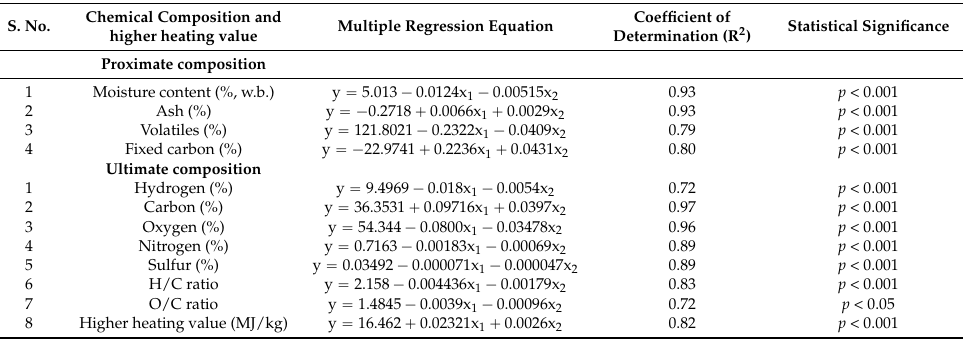
Table 4. Multiple regression equations for the chemical and energy properties.